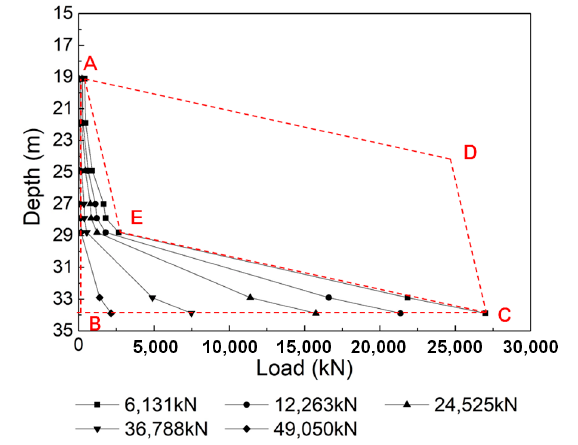
Figure 6. Estimation of the top-down load distribution from the bi-directional load test (TP 2). Table 3. Summary of calibrated elastic modulus and load ratio.